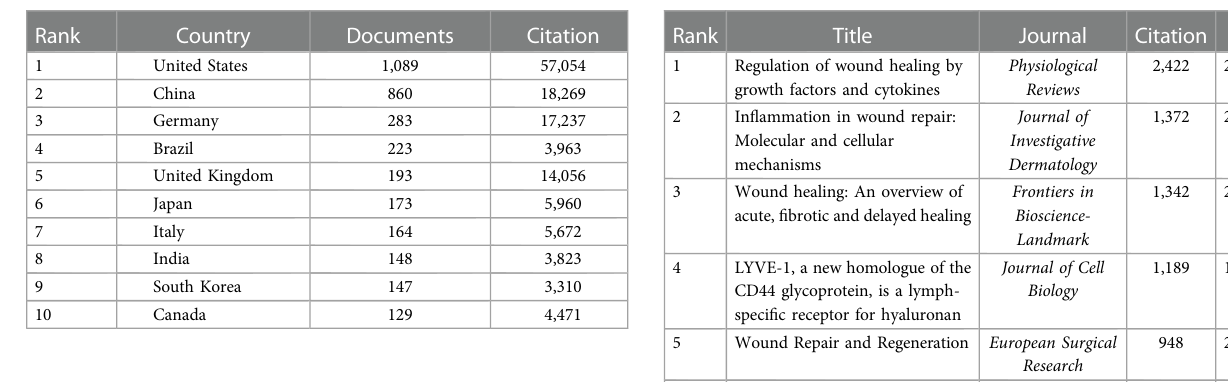
TABLE 1 The top 10 productive countries/regions.